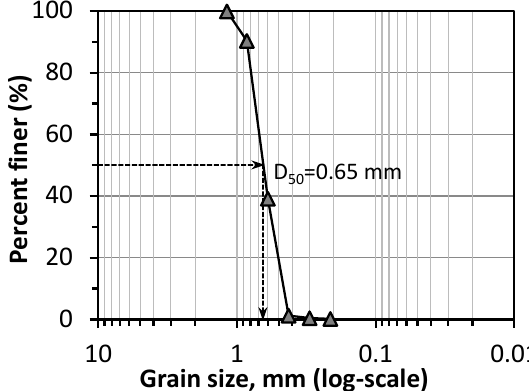
Figure 1. Grain size distribution of Mikawa sand.